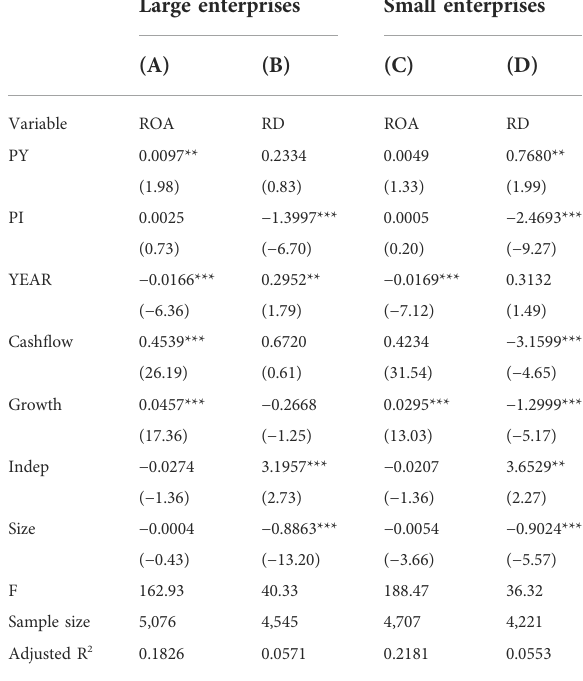
TABLE 6 Regression results for companies of different